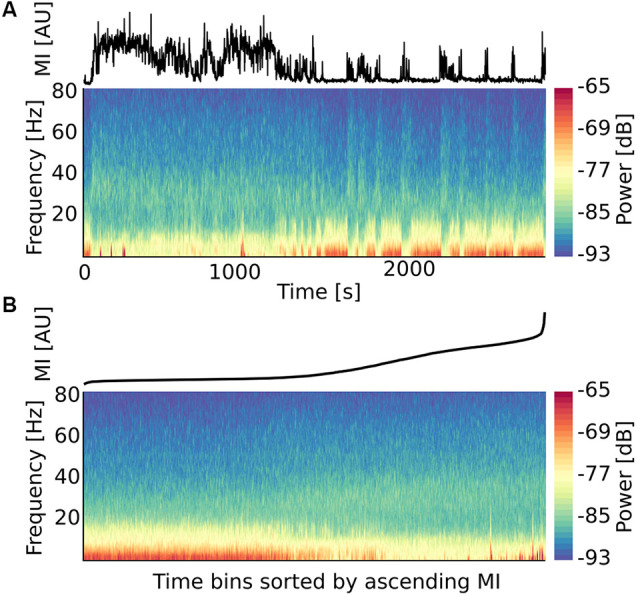
Representation of a spectral power chart as a function of motion index reveals a tight correlation between motor state and oscillations at specific frequency bands. (A) Example of a time-frequency-power chart computed from local field potential (LFP) signals from the right motor cortex of a bilateral 6-OHDA rat extended for 40 min with the corresponding motion index. (B) The same chart but sorted according to the ascending motion index.